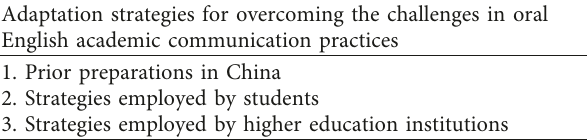
Table 4: Adaptation strategies for overcoming the challenges in oral English academic communication practices. Adaptation strategies for overcoming the challenges in oral